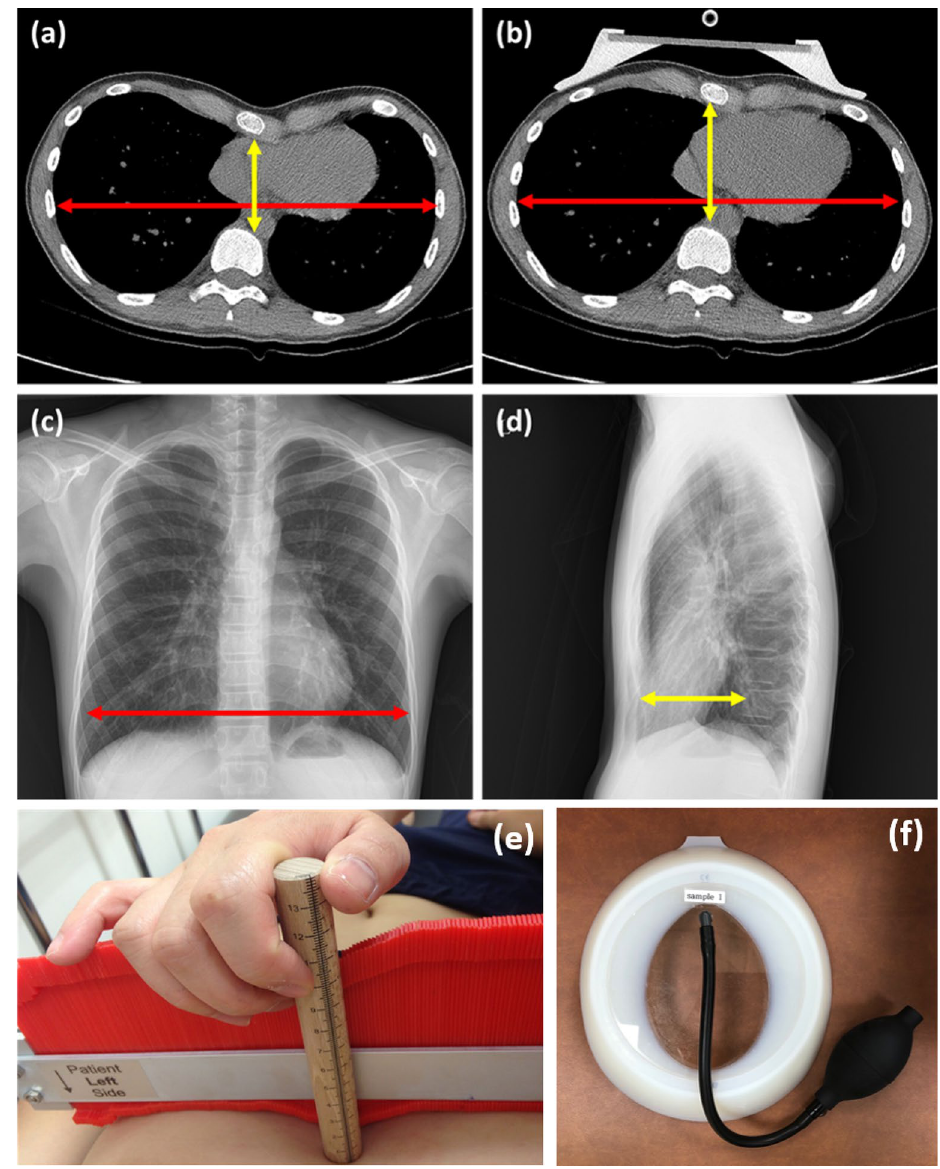
Figure 1. Evaluation of pre-treatment and expected improvements in thoracic indices. ( a ) Chest computed tomography (CT) taken before vacuum bell application is shown. Haller index was derived by dividing the largest horizontal diameter inside the ribcage (red arrow) by the anteroposterior diameter (shortest distance between the vertebrae and sternum, yellow arrow). ( b ) Chest CT taken after vacuum bell application is shown. Expected improvement in Haller index was measured as described above. ( c ) Posterior-anterior (PA) view on chest radiograph is illustrated. The greatest transverse diameter (largest horizontal diameter within the ribcage) was measured (red arrow) ( d ) Lateral view on chest radiograph is shown. The anteroposterior diameter (shortest distance between vertebrae and sternum) was measured (yellow arrow). Haller Index was calculated by dividing the transverse diameter by anteroposterior diameter. ( e ) Measurement of depth of PE. The anteroposterior distance of the deepest point of the sternum, was measured with the patient in a horizontal supine position on a flat table during deep inhalation using a designed scale rod. ( f ) Vacuum bell device (largest one). They were supplied by Eckart Klobe (https:// eckar tklobe. com, Mannheim,